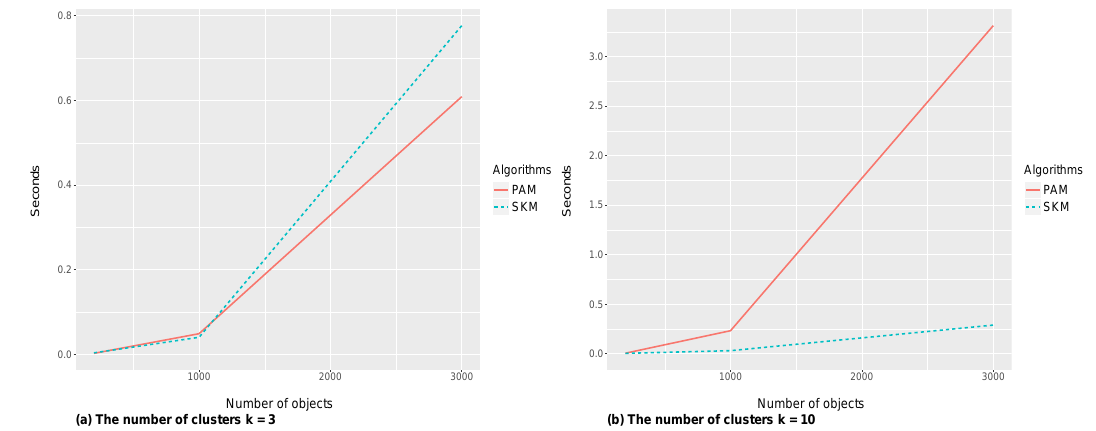
Figure 4. Benchmarking of PAM and SKM for k = 3 ( a ) and k = 10 ( b ) with set . seed ( 2019 )